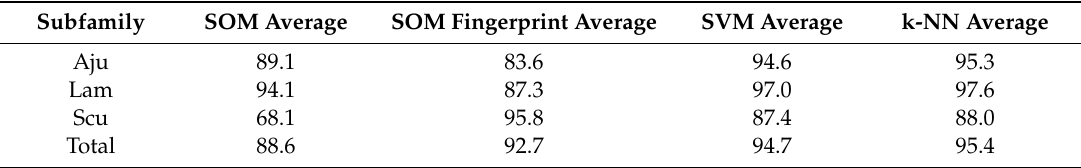
Table 7. Summary of test match (%) corresponding of the results obtained 5-fold models using SOM, SVM and k-NN algorithm of the subfamily Aju, Lam and